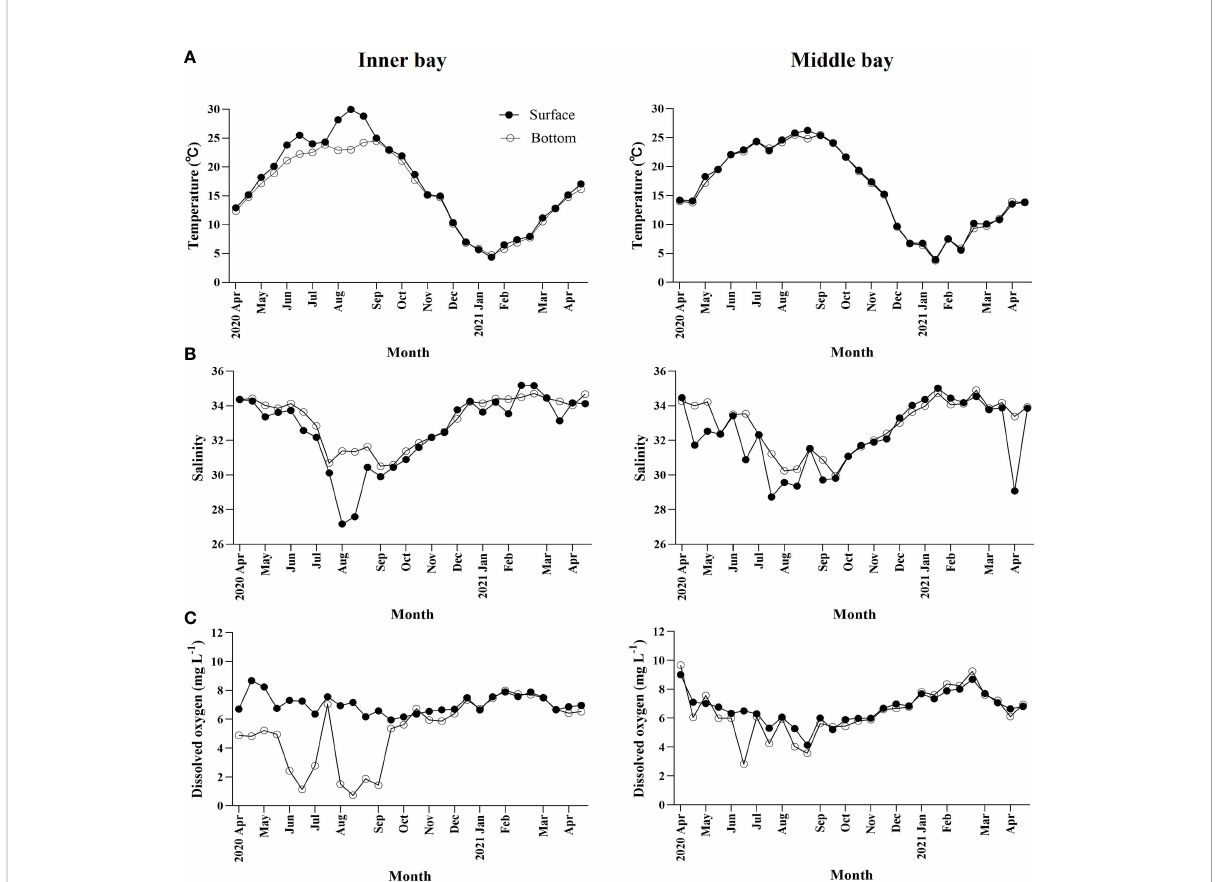
DO concentration ranged from 6.0 to 8.6 mg L -1 at the surface and from 0.7 to 8.0 mg L -1 at the bottom of the inner bay (Figure 2C). In spring and summer, DO concentration was high in the surface. Hypoxia in which the bottom DO concentration decreased to less than 2 mg L -1 was observed fi ve times from June to September when the surface water temperature was high. In autumn and winter, DO concentration was similar in the surface and bottom. In the middle bay, DO concentration ranged from 4.1 to 9.0 mg L -1 at the surface and from 2.8 to 9.7 mg L -1 at the bottom, and DO concentrations did not decrease below 2 mg L -1 . Total Chl- a concentration ranged from 0.7 µg L -1 to 7.8 µg L -1 (Figure 3A) in the inner bay. Total Chl- a concentration also appeared as two peaks in mid-August and late-September (7.8 m g L -1 and 7.6 m g L -1 , respectively). In December and January, two peaks were observed, which were relatively lower than in summer. In the middle bay, the total Chl- a concentration ranged from 0.5 µg L -1 to 5.3 µg L -1 , reaching a peak in late-June (5.3 m g L -1 ), and the fl uctuation range was lower than that of the inner